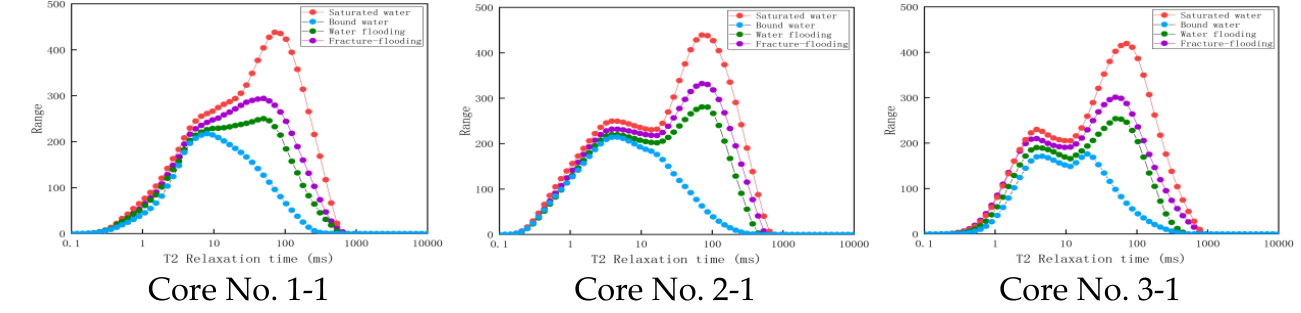
Figure 5. NMR T 2 spectrum curves of different displacement states.